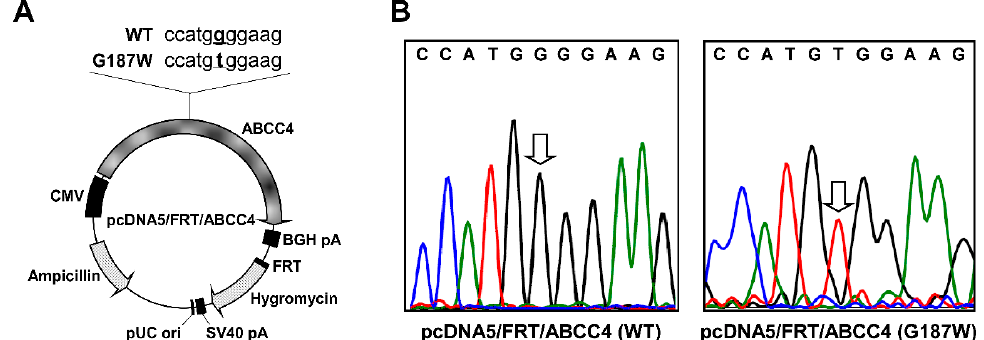
Figure 2. ( A ) Schematic illustration of the pcDNA5/FRT/ABCC4 vector. The partial cDNA sequences at position 554 to 564 in ABCC4 (WT) and (G187W) cDNA are indicated. The base at position 559 is indicated by bold text with underline. ABCC4, ABCC4 cDNA; BGH, bovine growth hormone; CMV, cytomegalovirus; pA, polyadenylation sequence; pUC ori, pUC vector origin of replication; SV40, simian virus 40. ( B ) Electropherograms confirming nucleotide substitution (G > T) at position 559 in ABCC4 (WT) cDNA. The nucleotide at position 559 is indicated by arrow.